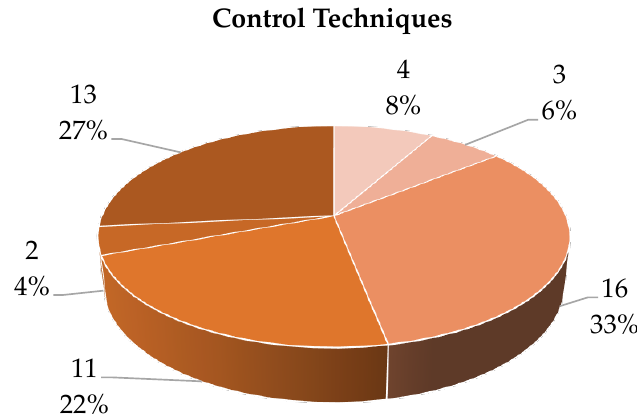
Figure 35. Control